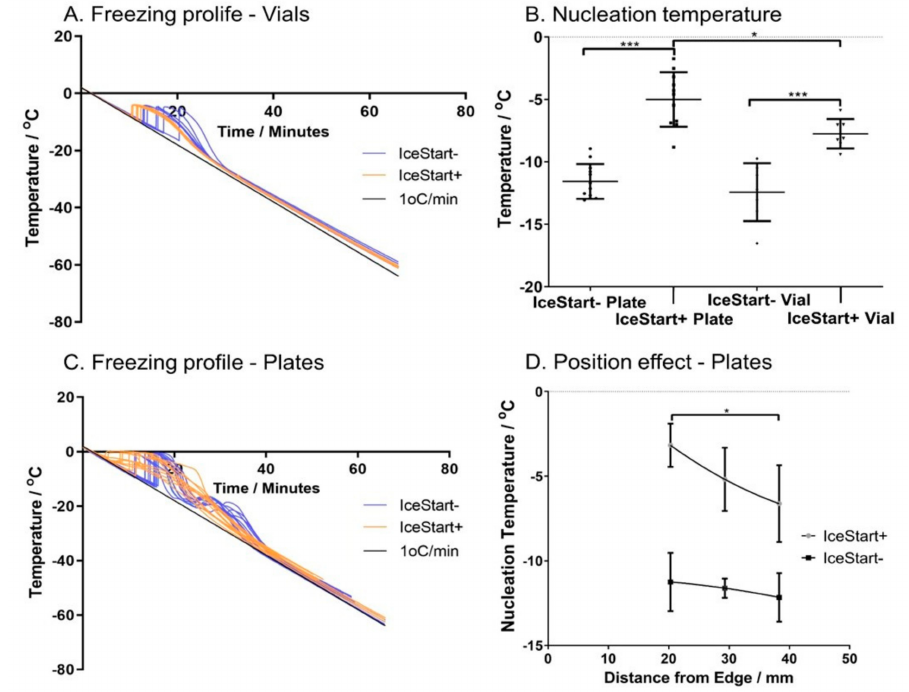
Figure 1. Freezing profiles and nucleation temperature. ( A ) Cryovial cryosolution temperature change over time with (orange) and without (blue) an ice nucleation device (IND). ( B ) Nucleation temperature of cryosolution in di ff erent conditions (IND +/ -) in both 96-well plates and cryovials. ( C ) The 96-well plate cryosolution temperature variation over time IND + : Orange, IND-: Blue. ( D ) Cryosolution nucleation temperature variation due to well distance from edge IND +/ -. (Vials: n = 4 replicates + 3 repeats per condition. 96-well plates: n = 4 repeats of three well positions. * p ≤ 0.05, *** p ≤ 0.001, bars represent ±